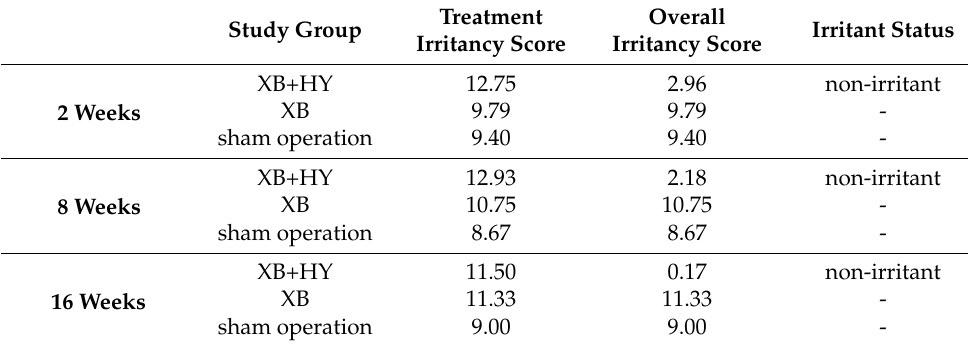
Table 4. Irritancy scores and irritancy status at 2, 8, and 16 weeks post